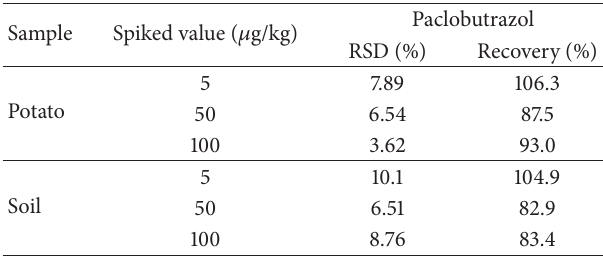
Table 1: Recoveries from two samples (five